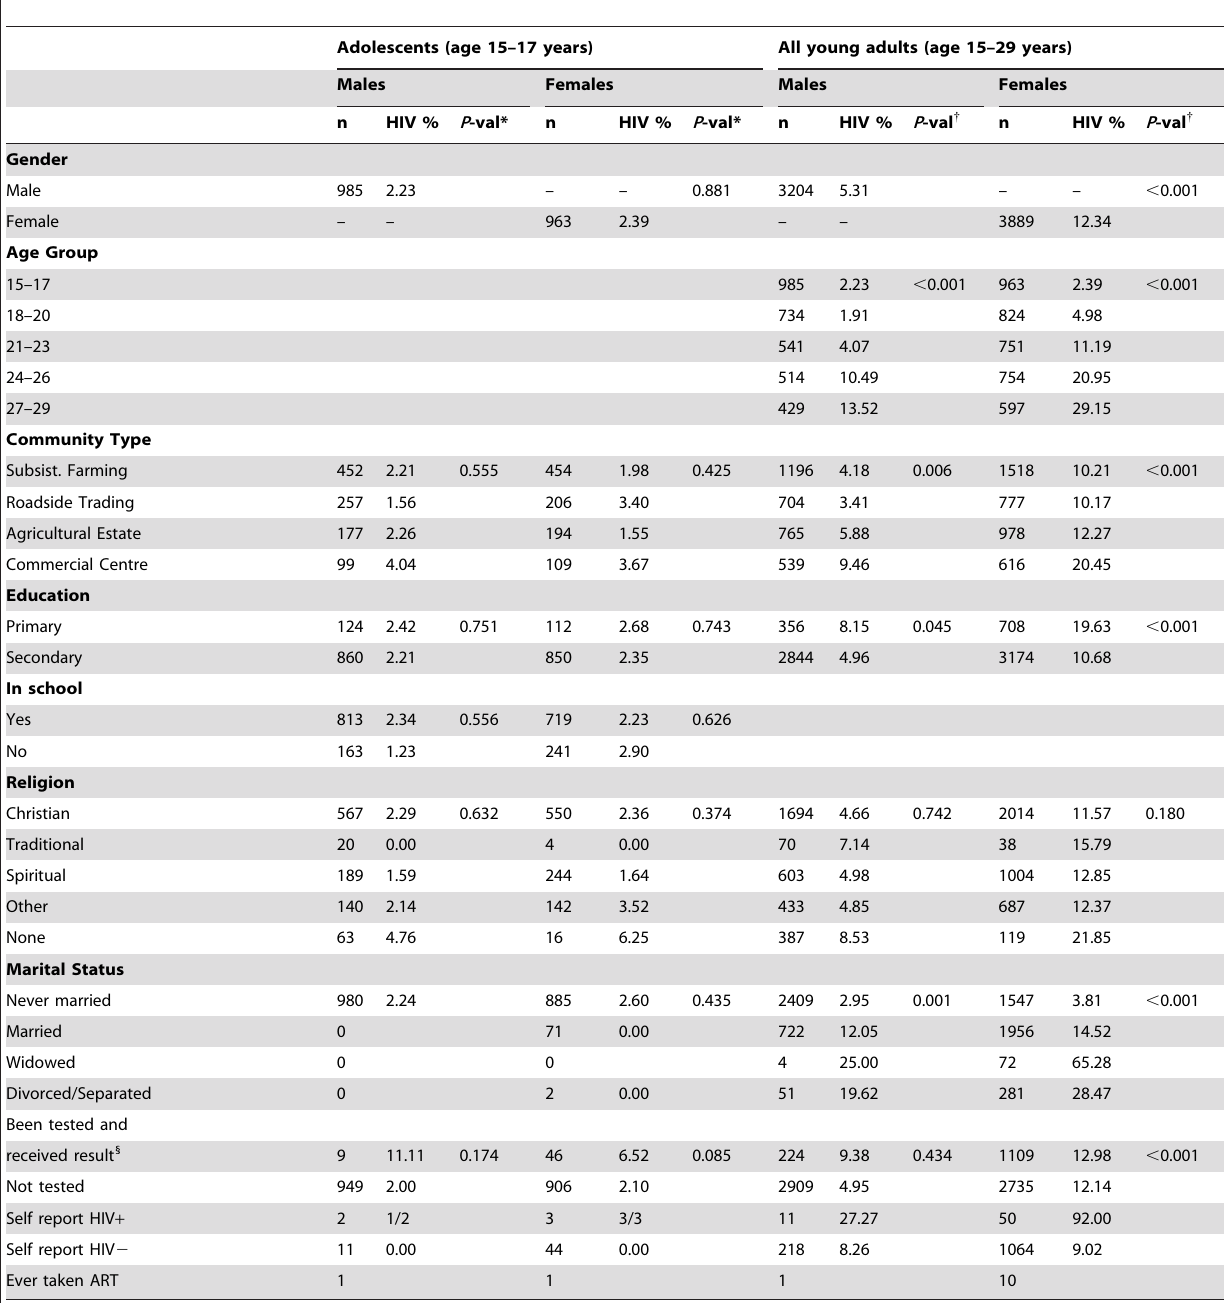
Table 1. Association between demographic characteristics and HIV infection amongst adolescents and all young adults, year 2006 to